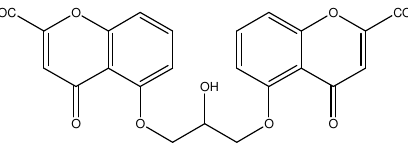
Cromolyn sodium Figure 1.